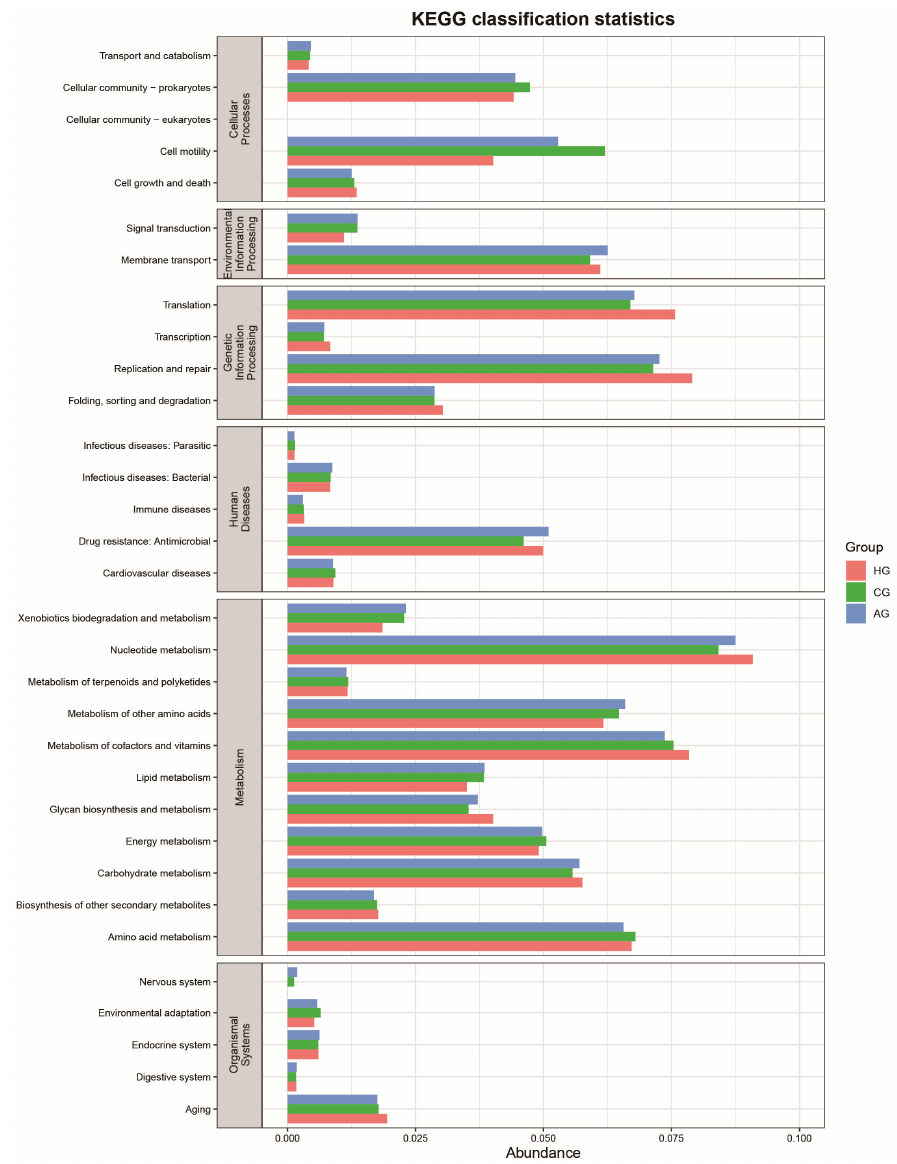
Figure 6. Function-predictive analysis of different